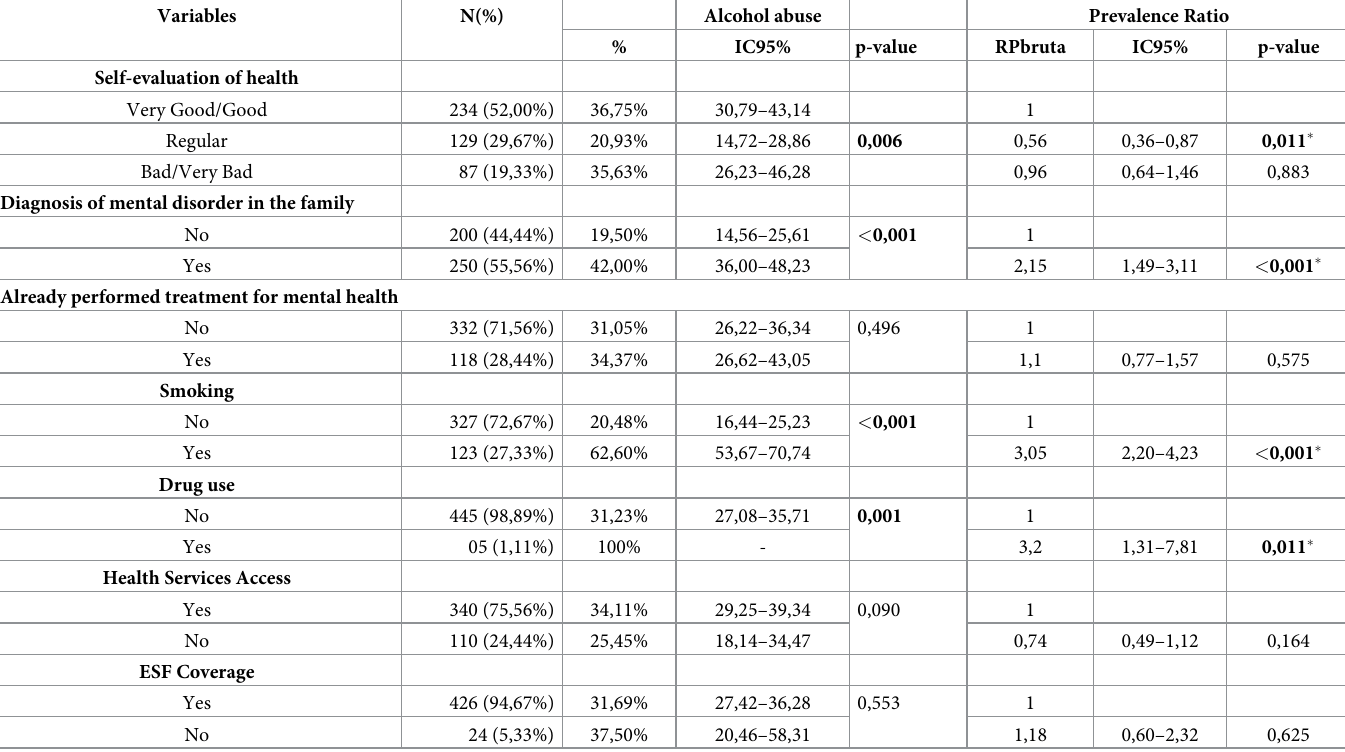
Table 2. Descriptive and bivariate analysis of alcohol abuse and its association with variables of health aspects among farmers in the municipality of Caico´-RN.